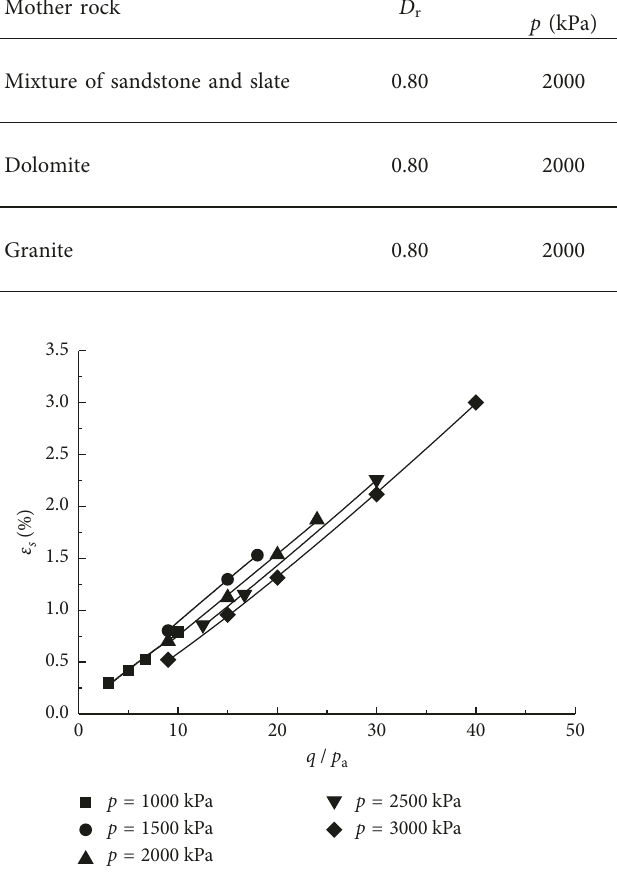
Figure 7: q / p a versus ε s curve (fitting of wetting shear strain).